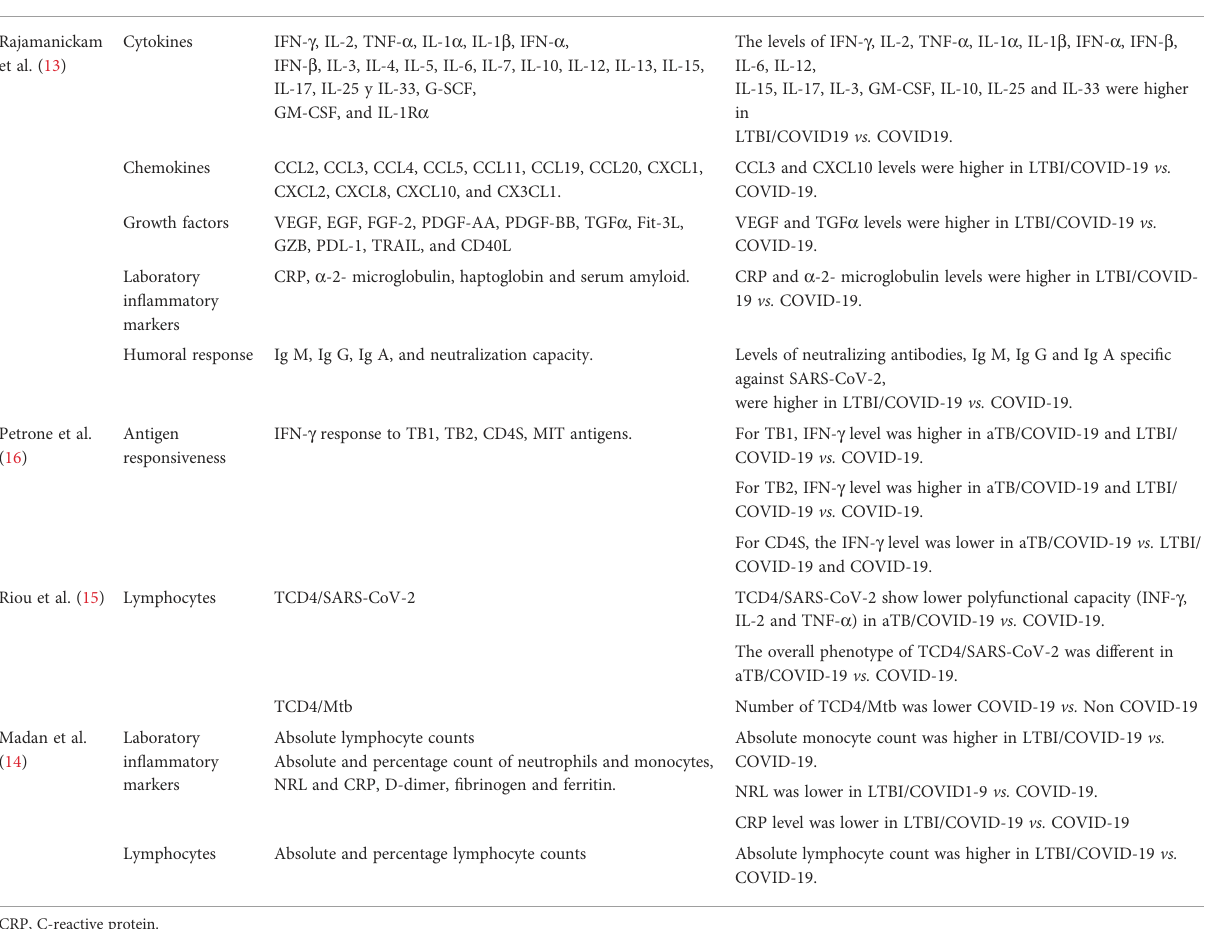
TABLE 2 Outcomes evaluated in studies assessing immune response in tuberculosis and COVID-19 co-infection (n=4). Study Immune response parameters evaluated Findings with signi fi cant difference